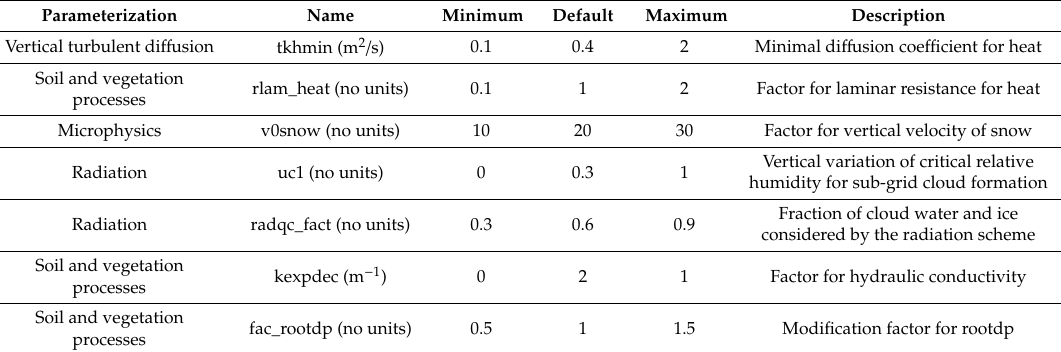
Table 1. List of parameters considered for sensitive study and related values. Values of kexpdec varied between 0 and 1 in the sensitivity runs, even if the default value is